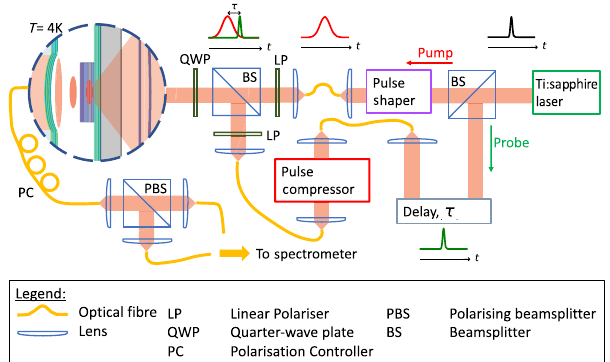
left: The output of a mode-locked Ti:sapphire laser (76 MHz repetition rate) is split into two arms: pump and probe. The pump is spectrally filtered using a pulse shaper setup. The probe pulse is sent through an optical delay line to control the time delay τ with respect to the pump pulse and a pulse compressor to compensate for linear dispersion in the optical